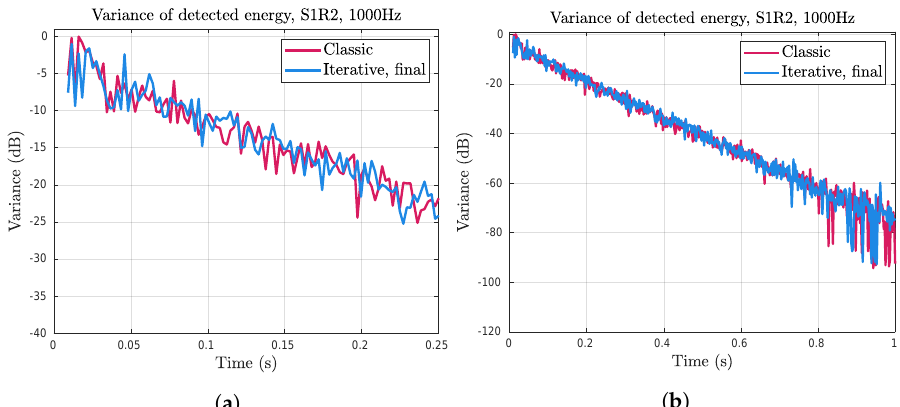
Figure 8. The variance of the detected energy in the impulse response for the classical and iterative algorithms, the first 0.25 s of the impulse response ( a ) and the first 1 s ( b ). The results are quite noisy, but similar.